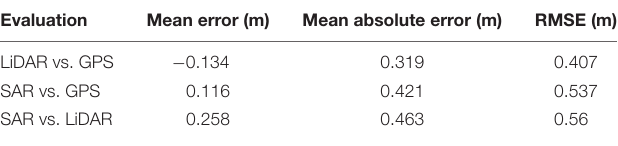
TABLE 2 | Calculated errors for the SAR-derived DEM and LiDAR relative to GPS ground-control points, as well as SAR vs. LiDAR.